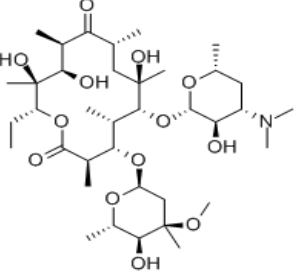
Figure 1. Chemical structure of the erythromycin A molecule.